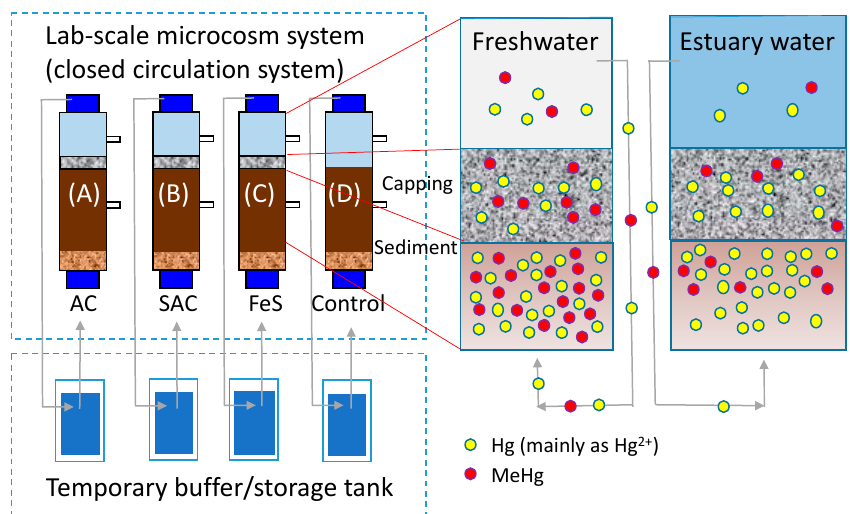
Figure 1. The diagram of vertical up-flow microcosms construction.